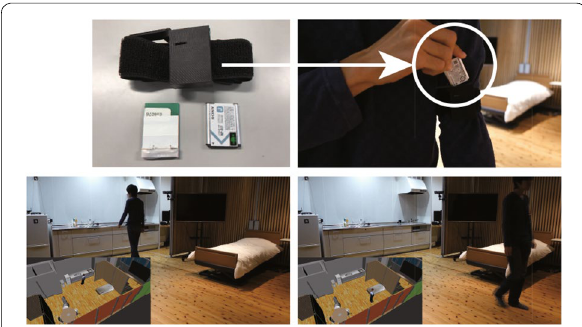
Fig. 5 The position of a user is measured by winding a wearable UWB tag in the